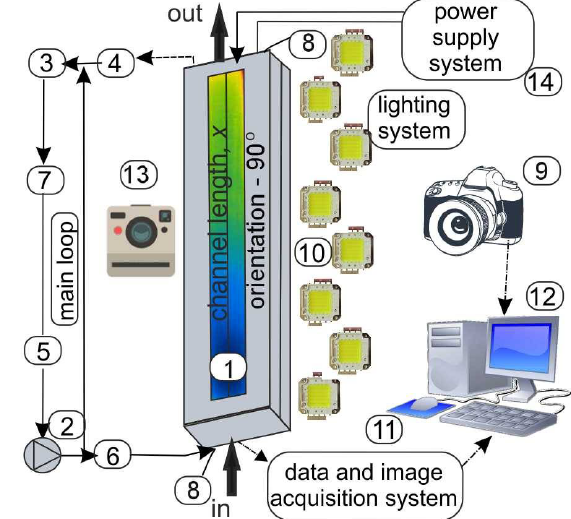
Fig. 1. The schematic of the main systems of the experimental setup, 1-a test section with a minichannel, 2-a gear pump, 3-a pressure sensor, 4-a tube-type heat exchanger, 5-a filter, 6-a mass flowmeter, 7-a deaerator, 8-a pressure meter, 9-a fast camera, 10-a high power LEDs (400 W), 11-a data acquisition station, 12-a pc computer, 13-an infrared camera, 14-a power supply system.